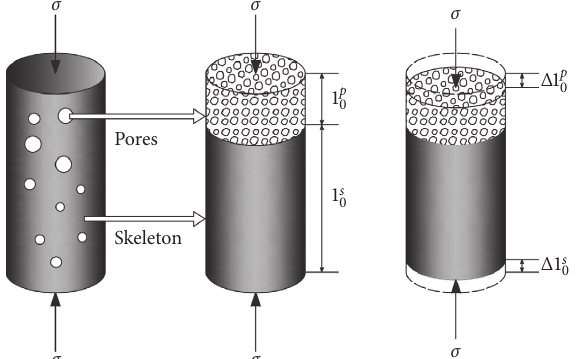
Figure 4: Diagram of the compression process of rock voids.